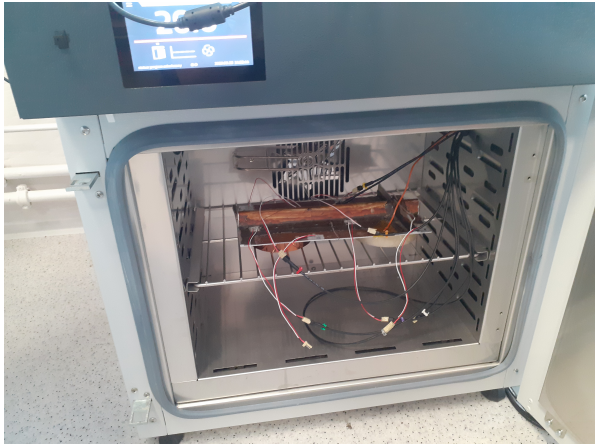
Figure 3. Specimen no. 1 placed in laboratory